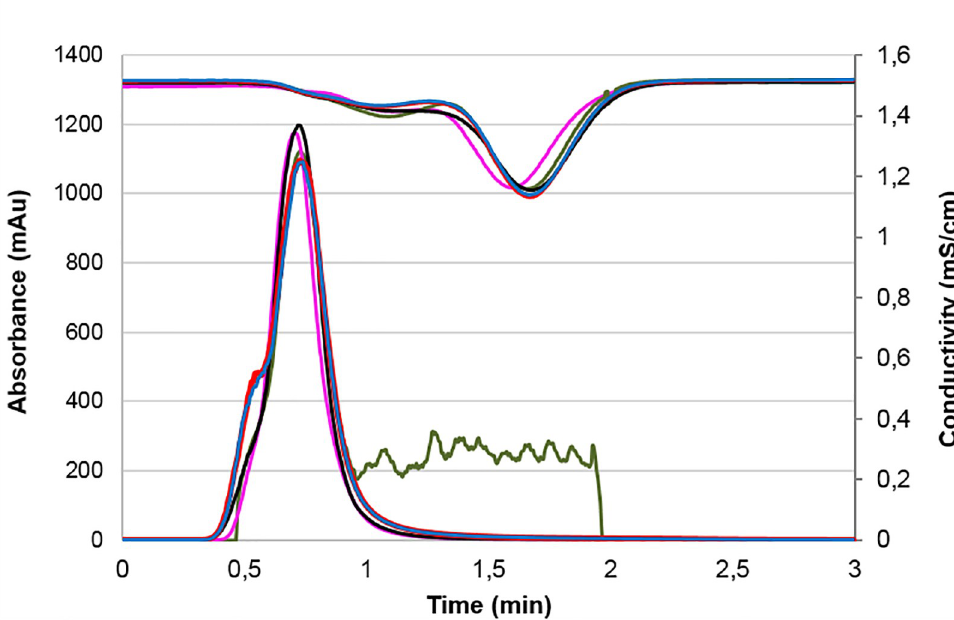
Fig 2. Molecular exclusion chromatographic profiles of 5G4 mAb and Herceptin. Absorbance at 280 nm (mAu) and conductivity (mS/cm) against elution time for different batches evaluated are shown. 5G4 mAb batch 1 (black), 5G4 mAb